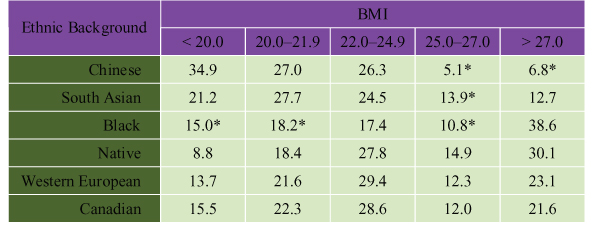
Percentage of Canadian Women in Each BMI Category as a Function of Ethnic Background Source: Statistics Canada, NPHS, 1996–1997